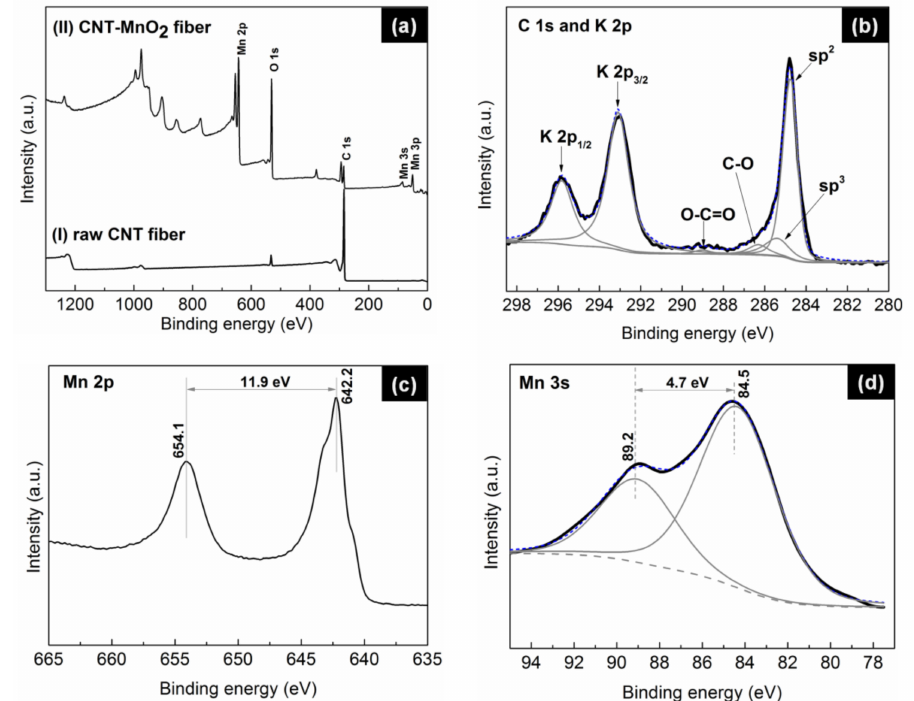
Figure 6. XPS survey spectra of ( a ) CNT fiber (bottom) and CNT–MnO 2 fiber (top). High-resolution XPS spectra from CNT–MnO 2 fiber: ( b ) C 1 s and K 2p, ( c ) Mn 2p, and ( d ) Mn 3 s peaks. The splitting width of the doublet peaks in Mn 3 s was 4.7 eV. Table 1. Surface functional components obtained from the deconvolution of the C 1 s peak